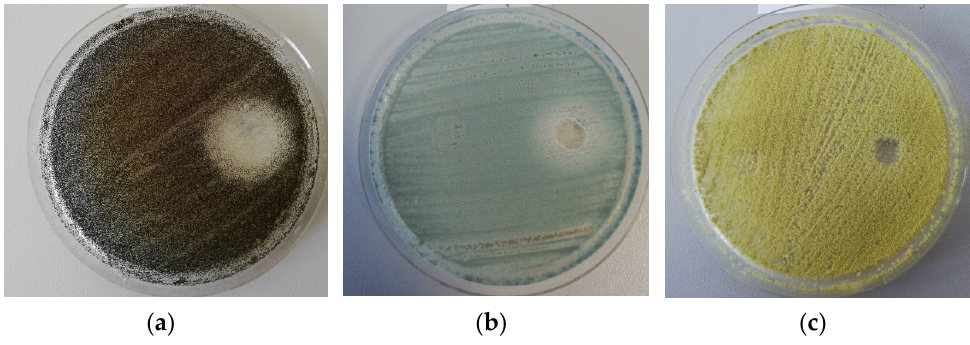
Figure 3. Example of the disk diffusion screening assay of the antimicrobial activity of the tested A. sativum extract against A. niger ( a ), P. chrysogenum ( b ), and A. flavus ( c ) strains isolated from the wooden churches (the obverse of the colonies).